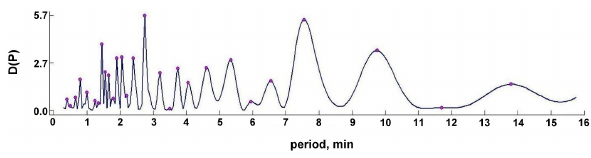
Figure 3. Periodogram for 91133 object, April 5,